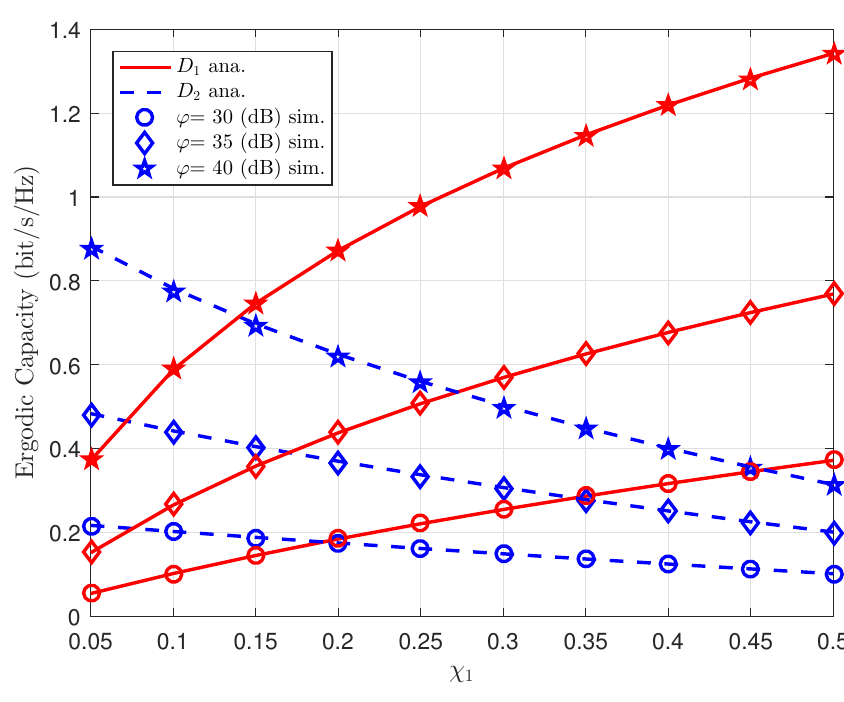
Figure 8. EC versus χ 1 for different ϕ